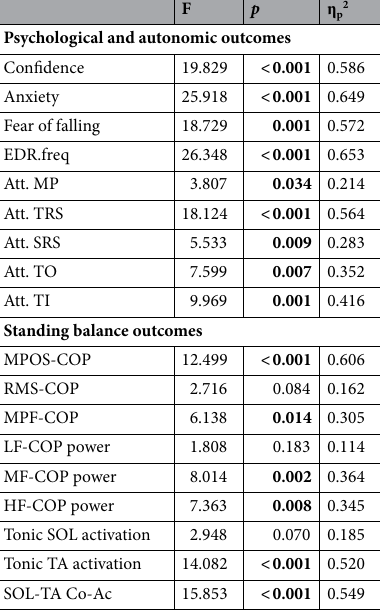
Table 4. One-way repeated measures ANOVAs for “Adaptor” subgroup. EDR.freq: non-specific electrodermal response frequency; Att.: attention toward; MP: movement processes; TRS: threat-related stimuli; SRS: self-regulatory strategies; TO: task objectives; TI: task-irrelevant information; MPOS: mean position; RMS: root mean square; MPF: mean power frequency; LF: low-frequency (0–0.05 Hz); MF: medium-frequency (0.5–1.8 Hz); HF: high-frequency (1.8–5 Hz); SOL: soleus; TA: tibialis anterior; Co-Ac: coactivation. Significant p-values (<0.05) are boldfaced.